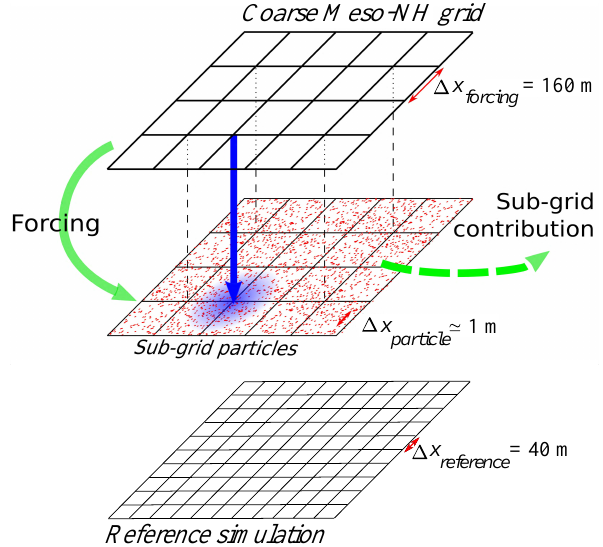
Figure 1. The downscaling scheme. Coarse fields are used to force a sub-grid particle system. The sub-grid fields are compared to a reference Meso-NH